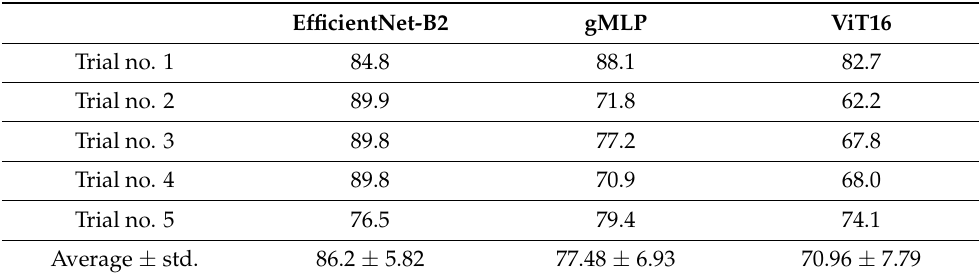
Table 6. Accuracy of the proposed architecture by applying learning from scratch. The accuracy is compared with the accuracies of gMLP and ViT16.